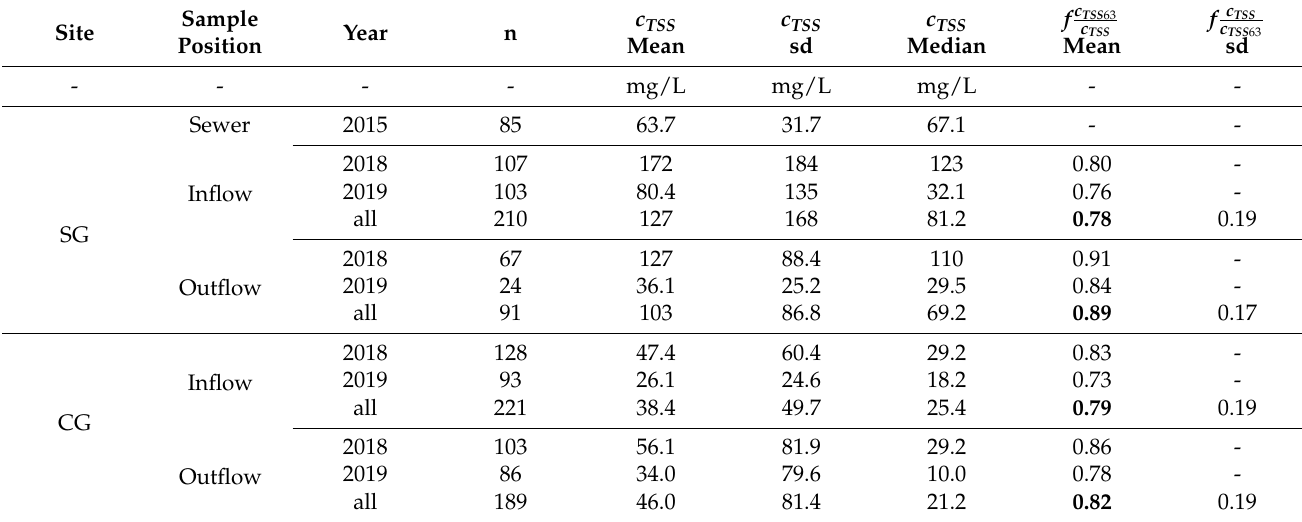
Table 2. Descriptive statistics of TSS concentration and TSS63 ratio from composite samples per site, sample position, and year with raw data. SG data are compared to previous sewer data from [23].